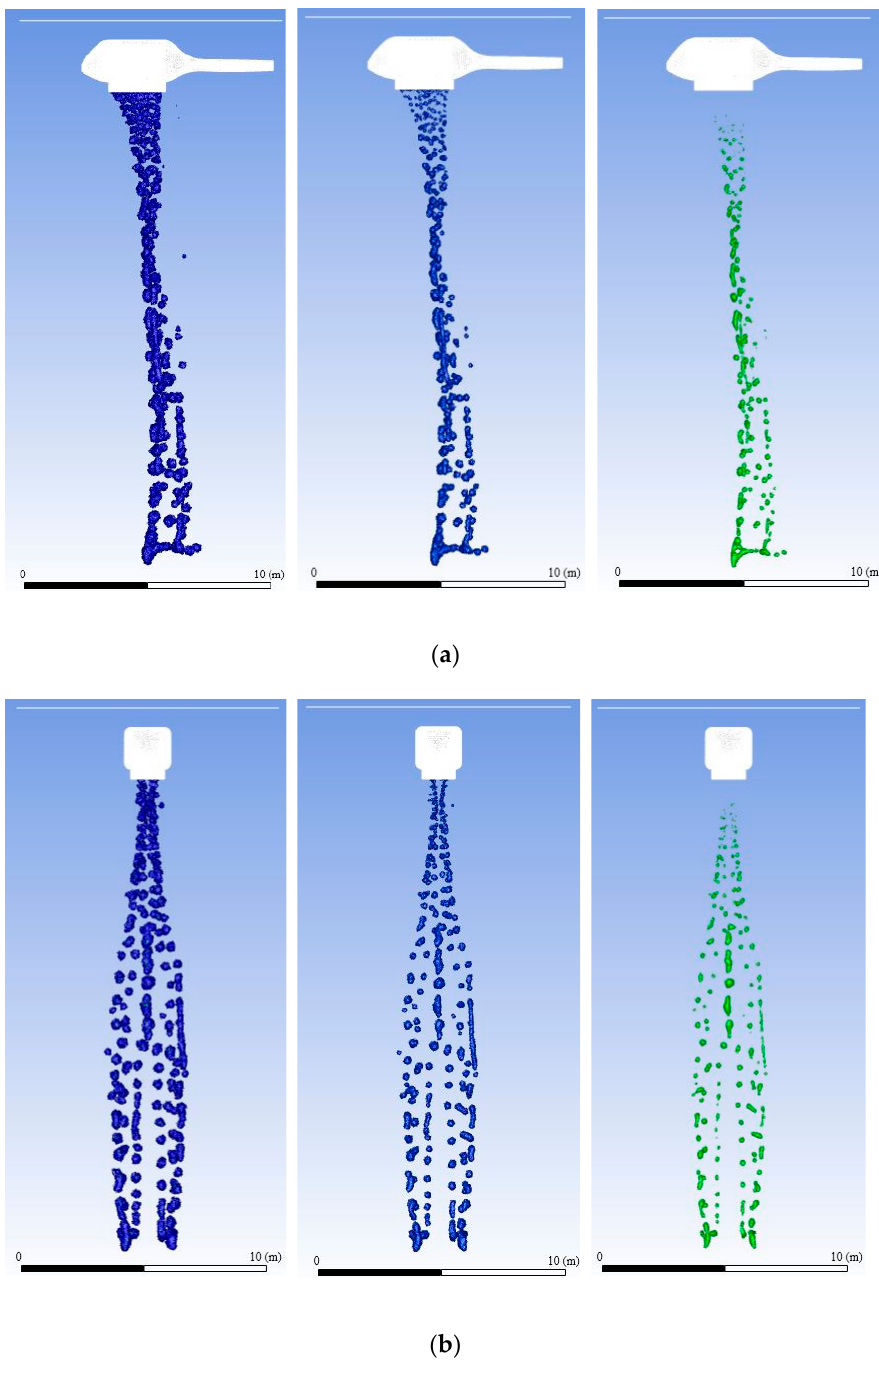
Figure 19. Contour surface of the two-phase, water–air volume fraction with fine meshes (the ground is at the ruler). ( a ) Contour surface and side view when the two-phase, water–air volume fraction was 0.01, 0.1, and 0.5, respectively, at t = 1.9 s. ( b ) Contour surface and front view when the two-phase, water–air volume fraction was 0.01, 0.1, and 0.5, respectively, at t = 1.9 s.